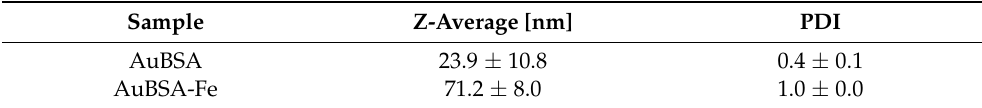
Table 1. Hydrodynamic diameter (represented by Z-average) and polydispersity (PDI) of nanocom- posites determined by DLS